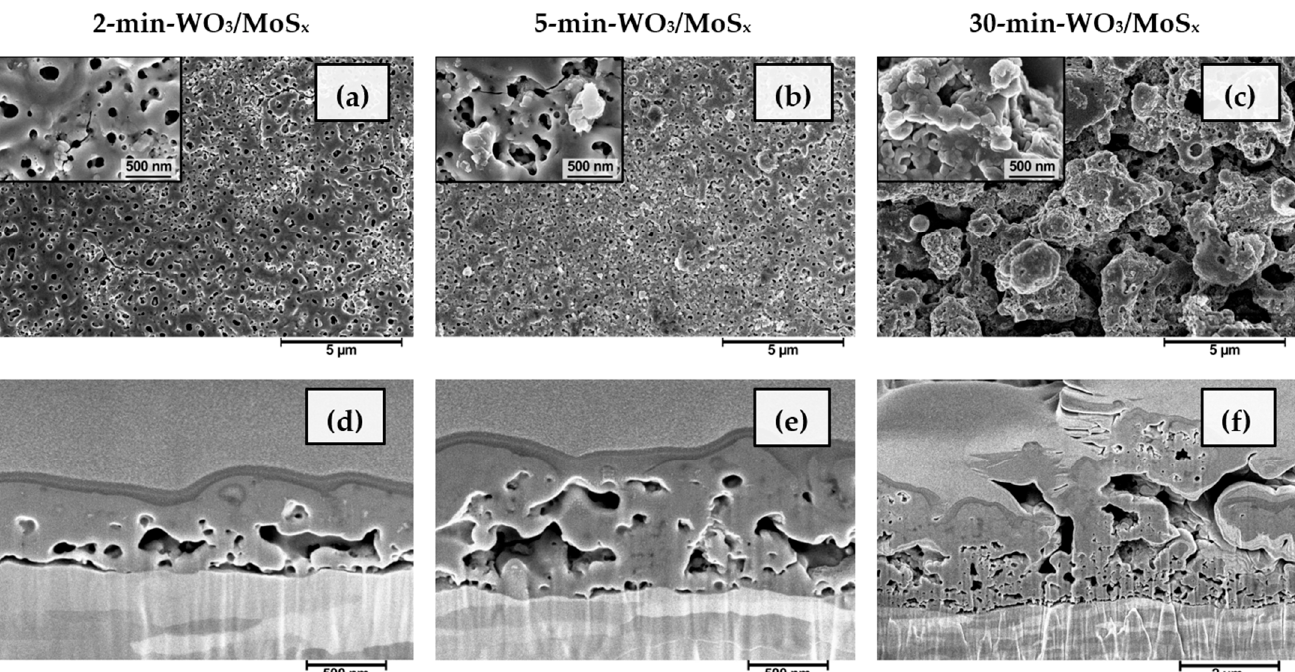
Figure 2. SEM surface morphology and FIB cross-sectional morphology of WO 3 /MoS x heterostruc- tures, obtained after synthesis for 2 min ( a , d ), 5 min ( b , e ), 30 min ( c , f ).